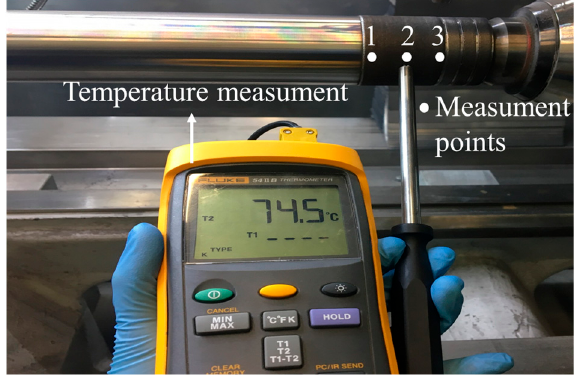
Figure 5. Measurement of the temperature of the last layer after each set of consecutive layers.